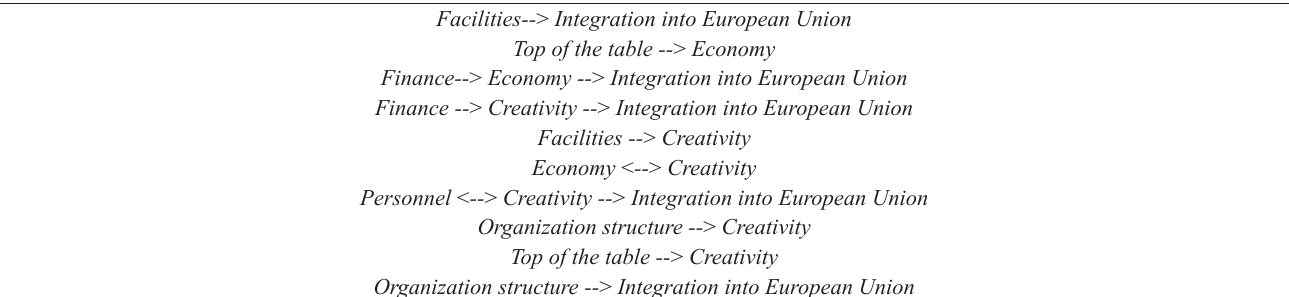
Table 3. Control sample – with no experience in management of sports clubs, but oriented towards a professional career in sports - statistical significant correlations based on Figure